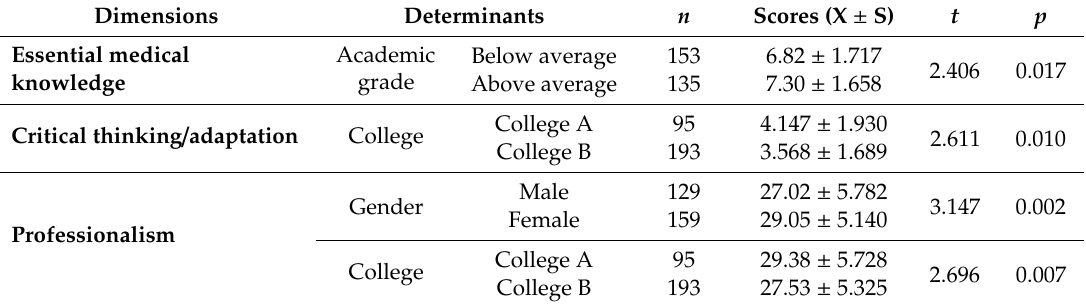
Table 5. Determinants are associated with the professional competence of respondents. Dimensions